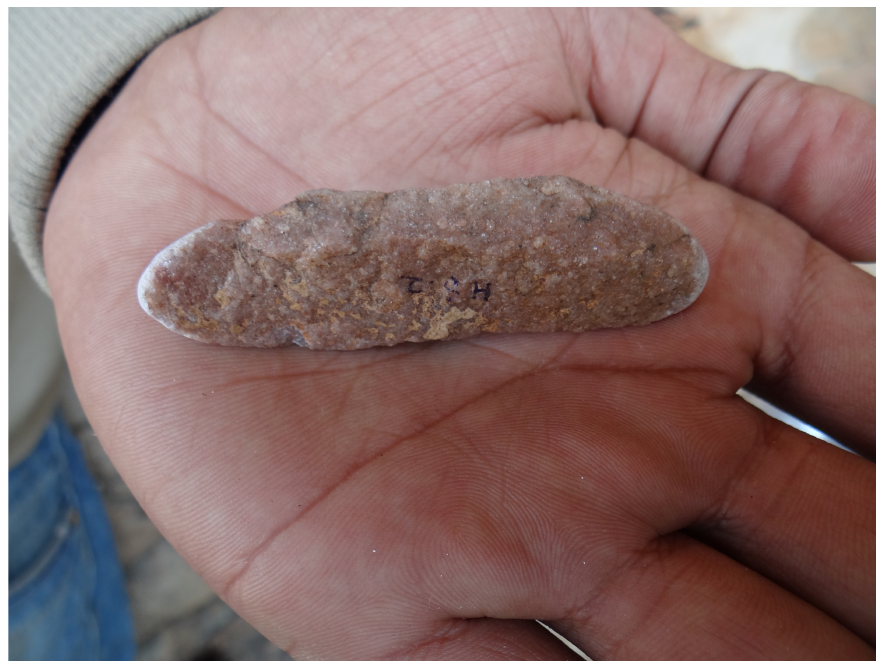
Figure 18. Small and elongated quartzite flake used as hammer stone from its both the ends to produce RC-10.